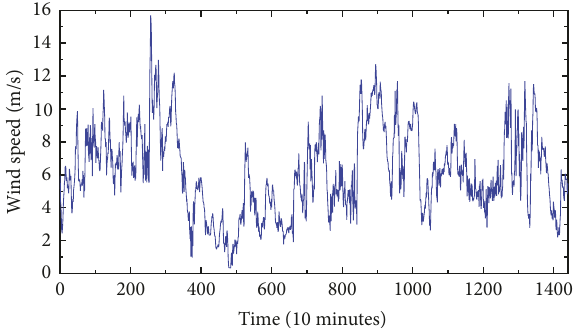
Figure 3: Original wind speed time series (Case